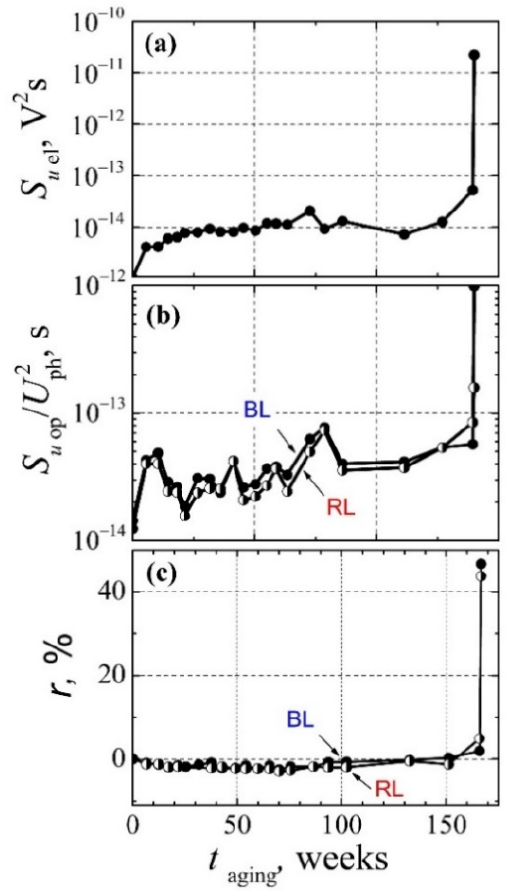
Figure 16. Dependences of the electrical ( a ) and the relative optical noise ( b ) spectral densities on the aging time at forward 100 mA current at 22 Hz frequency; ( c ) dependences of the cross − correlation coefficient between the electrical fluctuations and both optical blue (BL) and red (RL) light fluctuations on the aging time in the whole measured frequency range of 10 Hz–20 kHz at 100 mA current (solid dots, blue light; half-filled dots, red light). Table 3. Comparison of changes of the electrical and optical noise characteristics of the high-power white AlInGaN and InGaN LEDs during the long-term aging at RT.